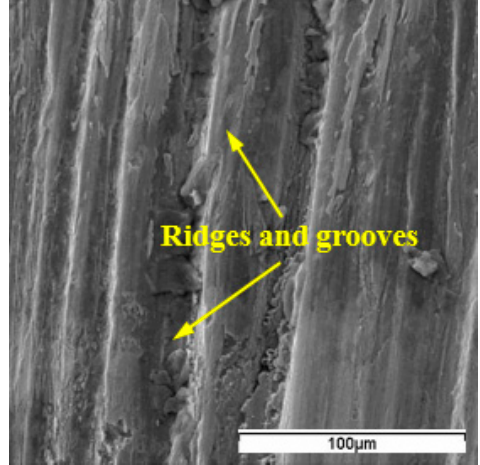
Figure 5. Ridges and grooves on the flank face of SX9.